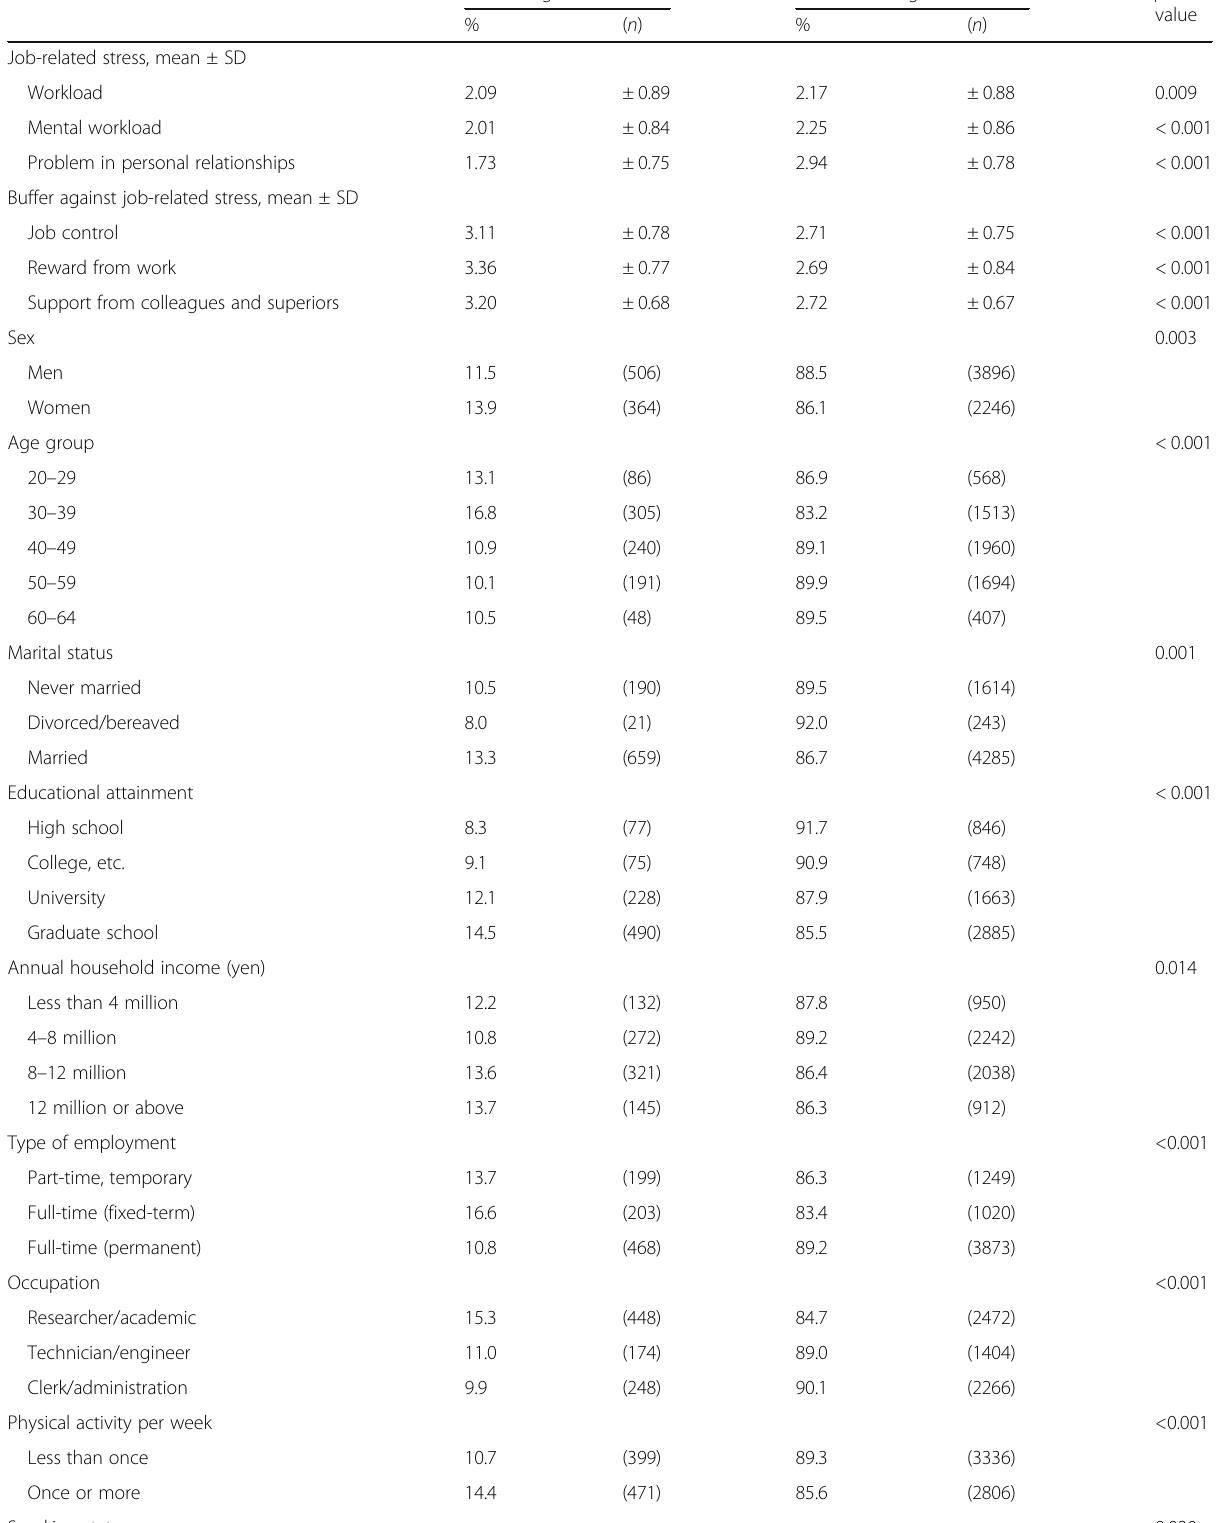
Table 2 Comparison of characteristics between flourishing and non-flourishing mental health ( n = 7012), Tsukuba, Japan (2017) Flourishing